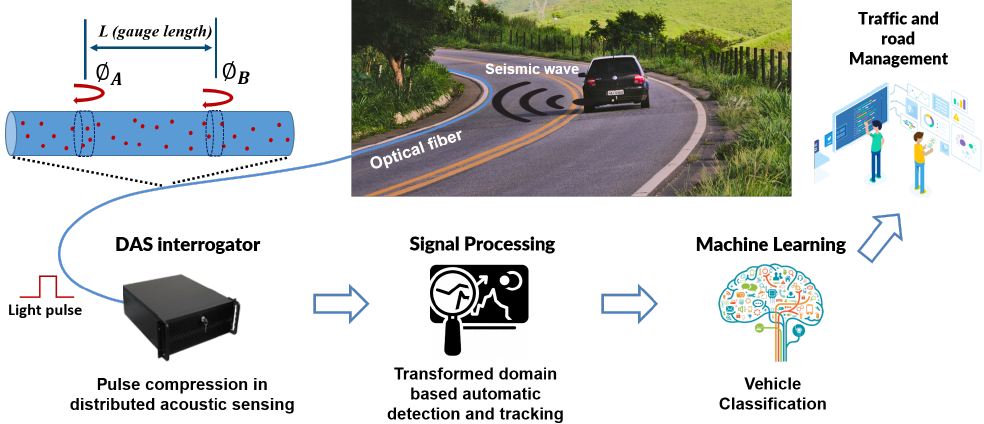
Figure 1. Schematic description of the automatic traffic monitoring system based on